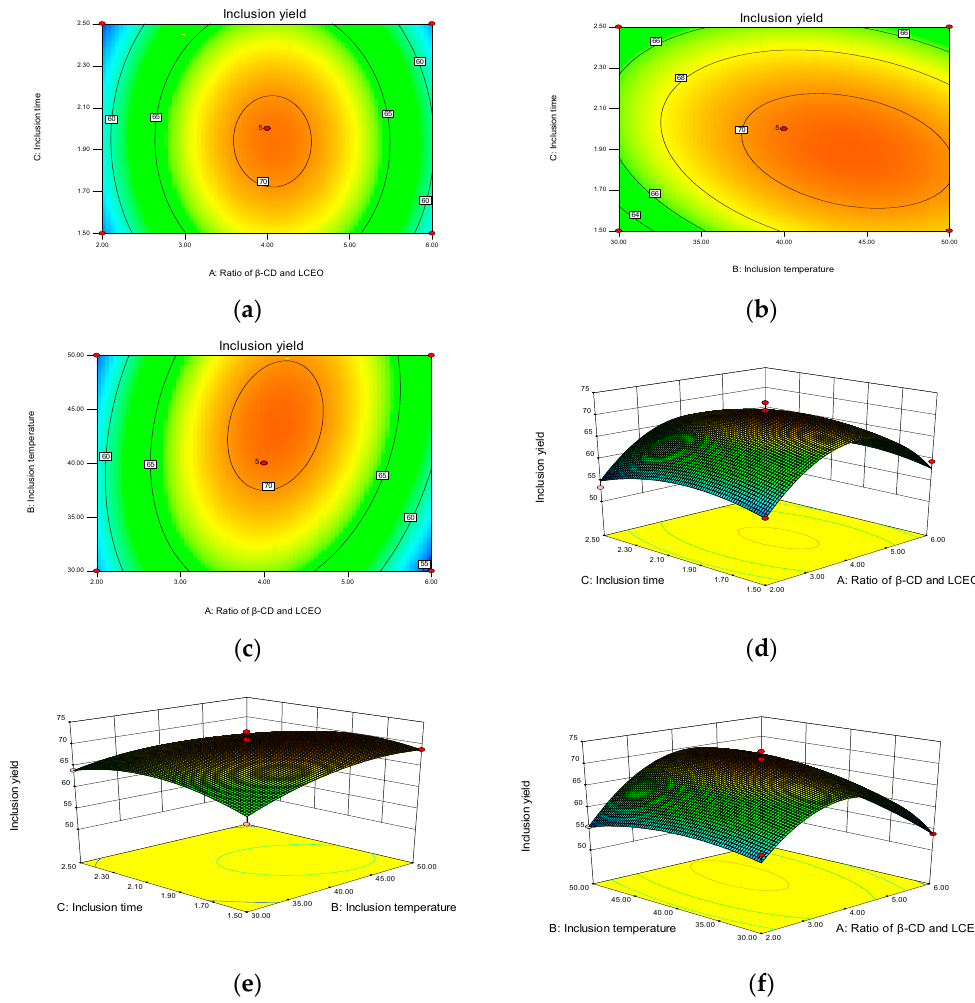
Figure 3. Contour plots ( a–c ) and response surfaces ( d–f ) showing effects of the interaction between ratio of β -CD and LCEO and inclusion time ( a , d ), inclusion time and temperature ( b , e ), and ratio of β -CD and LCEO and inclusion temperature ( c , e ) on inclusion yield.